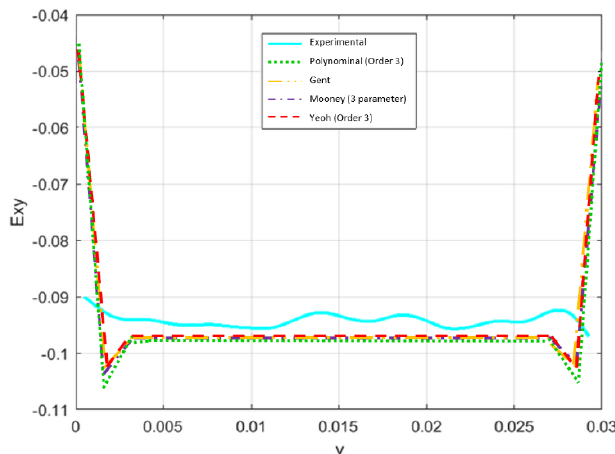
Figure 12. Shear strain obtained numerically and experimentally along the y-direction for 2 mm of PDMS.